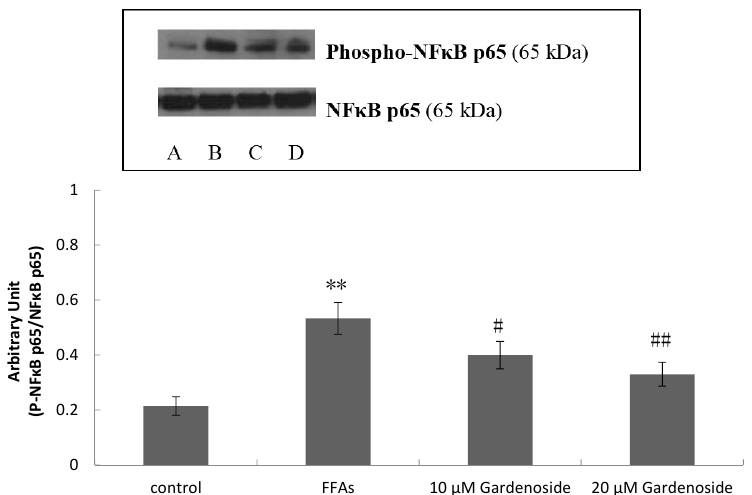
Figure 4. Changes of Phospho-NF κ B p65 Protein Expression. NF κ B p65 and Phospho-NF κ B p65 protein expression was assessed using immunoblot analysis in HepG2 cells after incubation with or without FFAs in the presence or absence of Gardenoside 10 or 20 µ M. HepG2 cells treated with DMSO were used as control ( A ), cells were induced by FFAs ( B ); cells were treated with Gardenoside 10 µ M ( C ); 20 µ M ( D ) for 24 h. Immunoblots are representative of three different experiments. ** p <